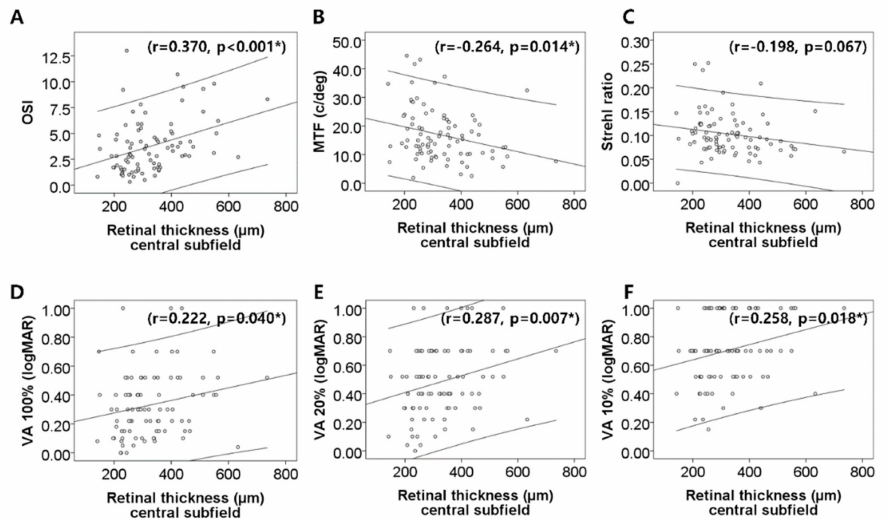
Figure 2. Correlation between central subfield retinal thickness and six optical quality values. A, B, C . Positive correlation is showed in OSI, and negative correlation is showed in MTF, Strehl ratio. D, E, F . Also, the central macular thickness positively correlated with predicted visual acuities(PVA) at contrast levels of 100%, 20%, and 10%. * Statistically significant by Pearson correlation test.